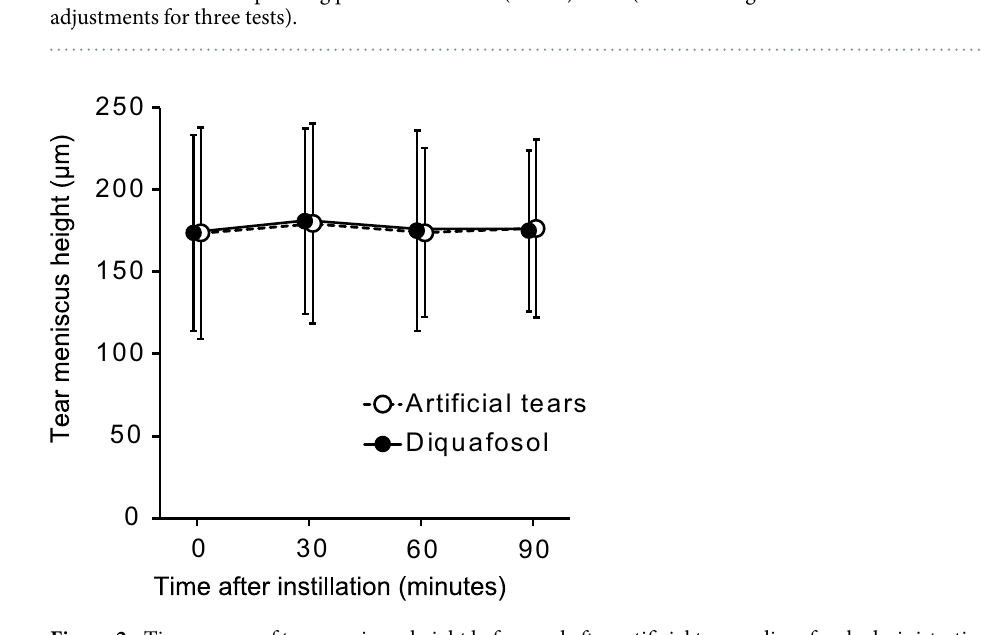
Figure 2. Time course of tear meniscus height before and after artificial tear or diquafosol administration. Data are means ± standard deviations ( n = 47). No values after administration differed significantly from the corresponding preadministration n (time 0) value (Wilcoxon signed-rank test with Bonferroni’s adjustments for three